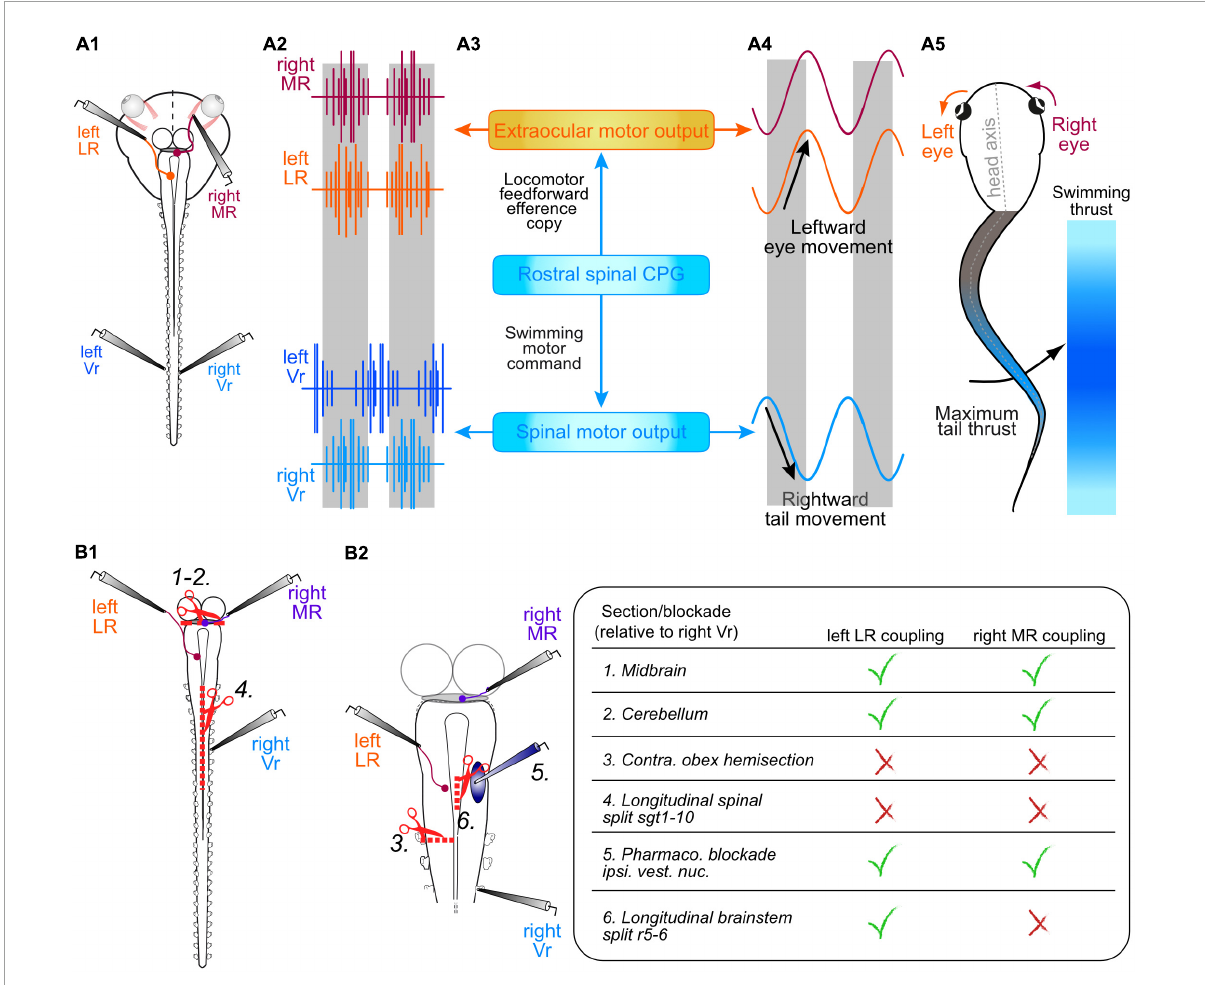
FIGURE2 Semi-intact preparation of Xenopus larvae for studying the influence of spinal motor network ECs in gaze stabilization during fictive locomotion. (A1–5) Schematic of a head-brainstem-spinal cord preparation (A1) depicting recordings (A2) of a left and right spinal ventral root (Vr, blue traces), a synergistic left lateral rectus (LR, orange trace) and a right medial rectus (MR, red trace) extraocular motor nerve; direct spino-ocular motor connectivity (A3) conveys a copy of swimming motor output from the spinal CPG circuitry to drive compensatory conjugate eye movements during head movements resulting from propulsive bending (A4) , mainly of the mid-tail region [indicated by color intensity grading in panel (A5) ]. (B1,2) Schematics of the isolated central nervous system (B1) illustrating various surgical lesions and drug application interventions that allowed identifying the ascending pathway from the spinal CPG circuitry to bilateral synergistic sets of LR and MR extraocular motoneurons; 1, 2, disconnection of the midbrain [1 in panel (B1) ] and cerebellum [2 in panel (B1) ]; 3, hemisection of the brainstem/spinal cord at the level of the obex on the side ipsilateral to a recorded (left) LR nerve (B2) whose burst activity occurred in phase with Vr bursts on the opposite (right) cord side; 4, longitudinal midline split throughout the first 10 spinal segments (B1) ; 5, injection of glutamatergic transmitter antagonists (CNQX + KYNA) into the vestibular nucleus to block central processing of sensory endorgan signals (B2) ; 6, midline incision at the level of the abducens nucleus in rhombomere 5 (B2) . These interventions and their respective effects on spino-ocular motor coupling to the synergistic left LR and right MR nerves are summarized in the table at